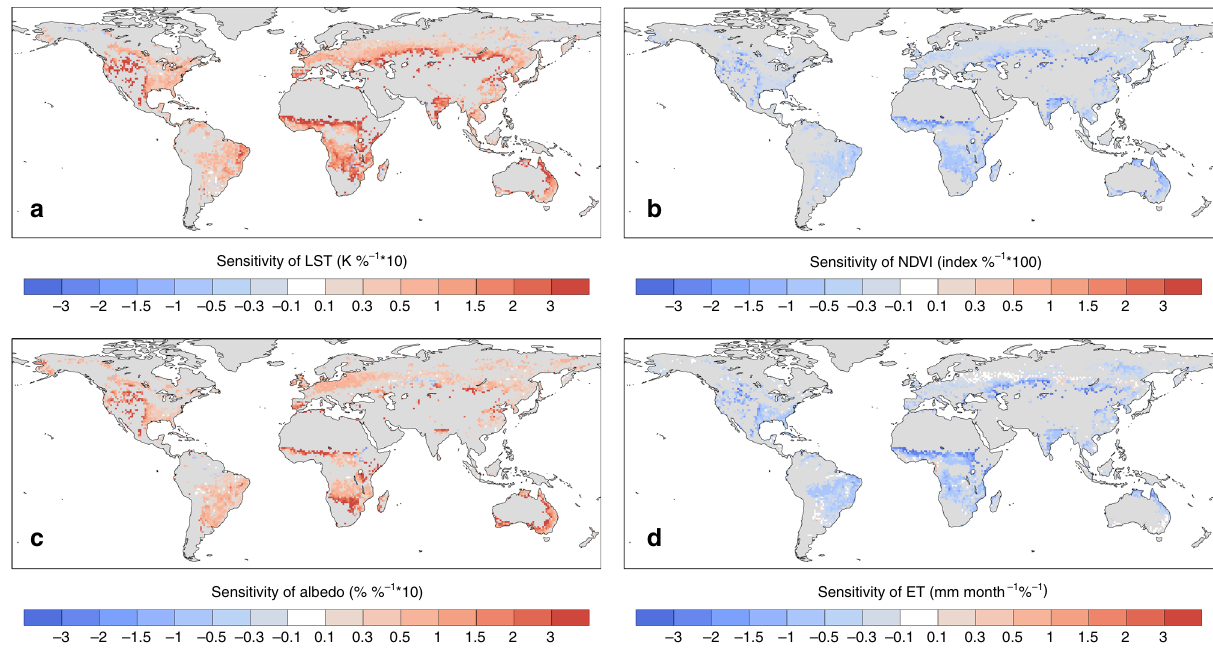
Fig. 1 Observed sensitivity to deforestation. a summer daytime land surface temperature (LST), b normalized difference vegetation index (NDVI), c albedo, and d evapotranspiration. The sensitivity is calculated based on the 0.05° Moderate Resolution Imaging Spectroradiometer (MODIS) satellite products within a 1° analysis window. The sensitivity is shown only where it is signi fi cant at a false discovery rate (FDR) adjusted p values of 0.05 and the range of deforestation (maximum minus minimum deforestation within the window) is greater than 10%. The fi gure was created using the NCAR Command Language (https://www.ncl.ucar.edu).